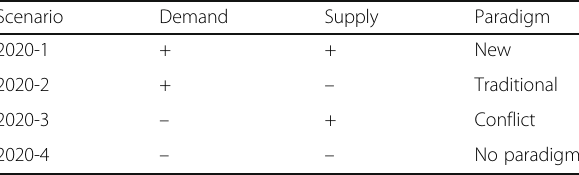
Table 2 Future scenarios based on supply of and demand for educational technology